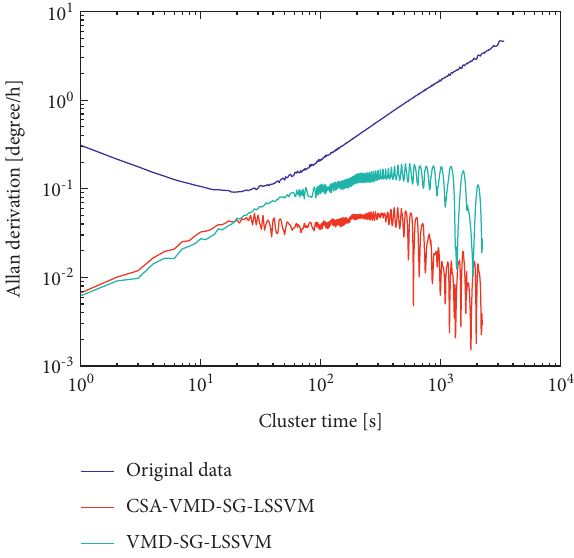
Figure 18: Allan analysis of